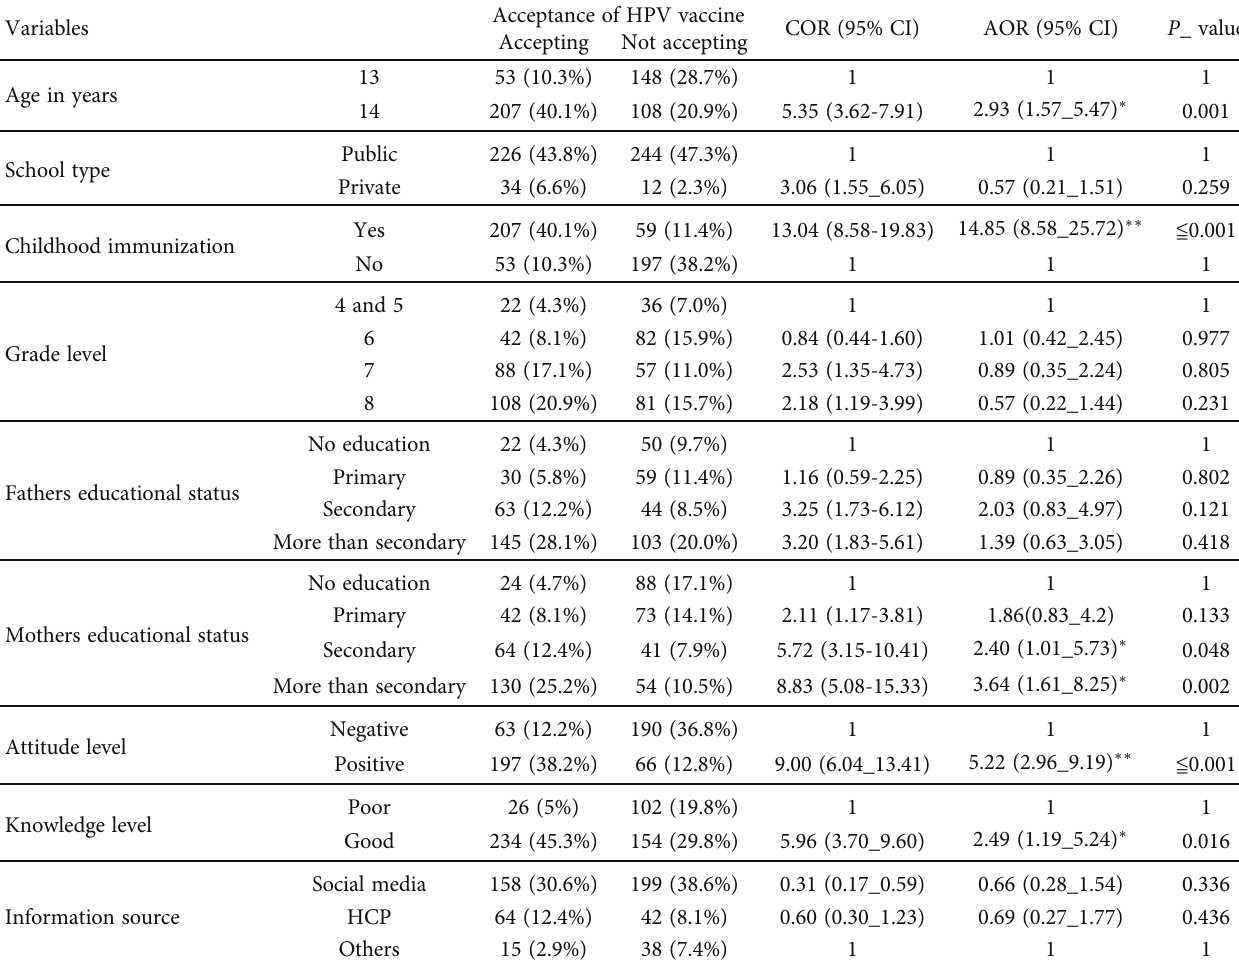
Table 6: Association between sociodemographic characteristics and other related factors with acceptance of HPV vaccination among primary school girls in Arba Minch town, Southern